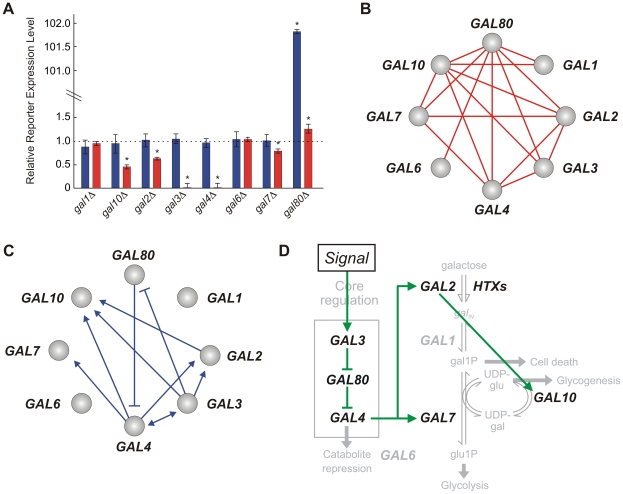
Analysis of reporter expression traits.(A) Relative traits for single GAL gene deletions, in presence (red) and absence (blue) of galactose. Asterisk marks significant effect (t-test p-value <0.05). (B) Signal-dependent genetic interactions (green: δI>0, red: δI<0, t-test p-value <0.05). (C) Inferred causal relationships. (D) Transitive reduction of the network in (C).